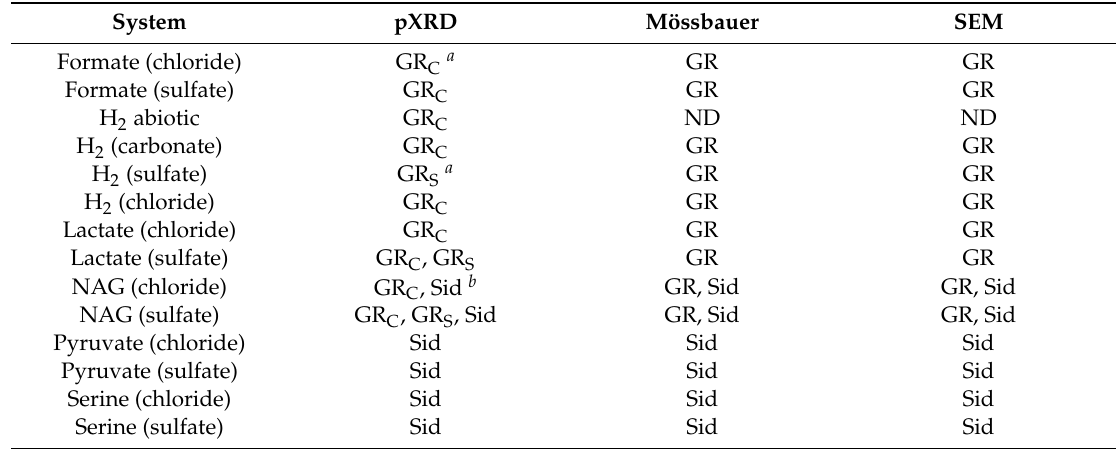
Table 3. Identification of secondary